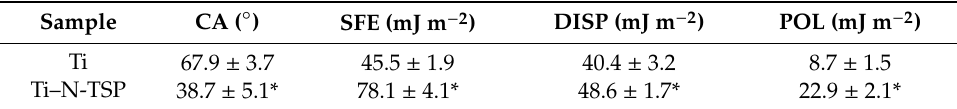
Table 1. Water contact angle (CA), surface free energy (SFE) and its dispersive (DISP) and polar (POL) components (mean ± standard deviation (SD)). * indicates statistically significant differences compared to Ti (p < 0.05).